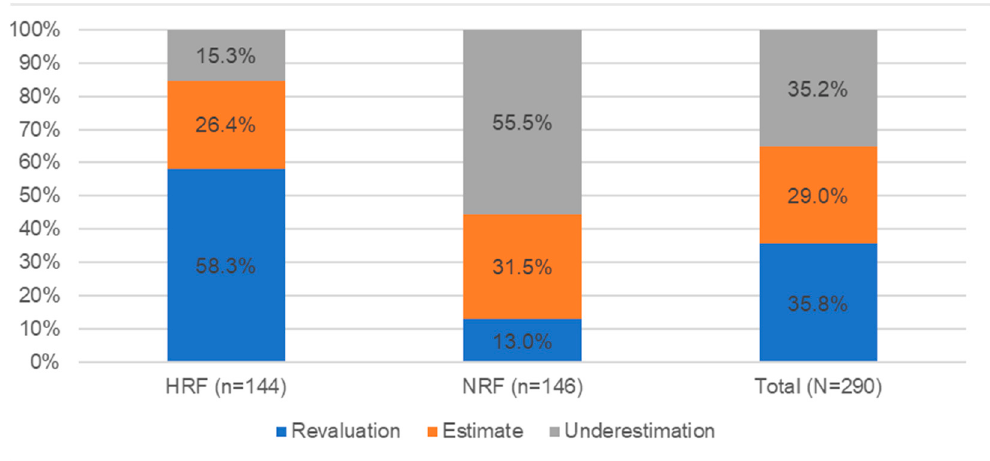
Figure 4. Level of calorie estimation of servings in student groups (N = 290).